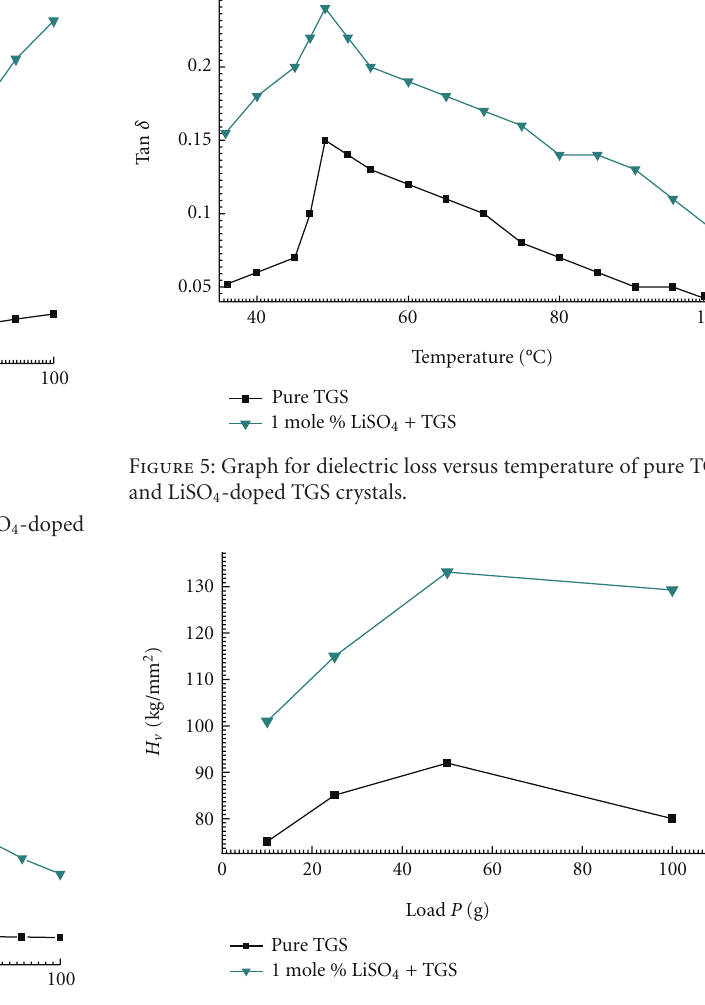
Figure 6: Variation of load versus Vicker’s microhardness number ( H V